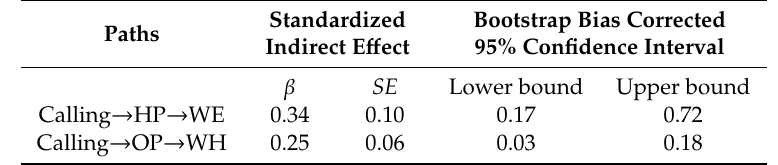
Figure 2. Structural model with standardized path estimate. Note: HP = harmonious passion; OP = obsessive passion; WE = work engagement; WH = workaholism; * p < 0.01. Control variables (age, gender, education level, and tenure) are not shown for simplicity. Table 2. Indirect relations for the structural model.